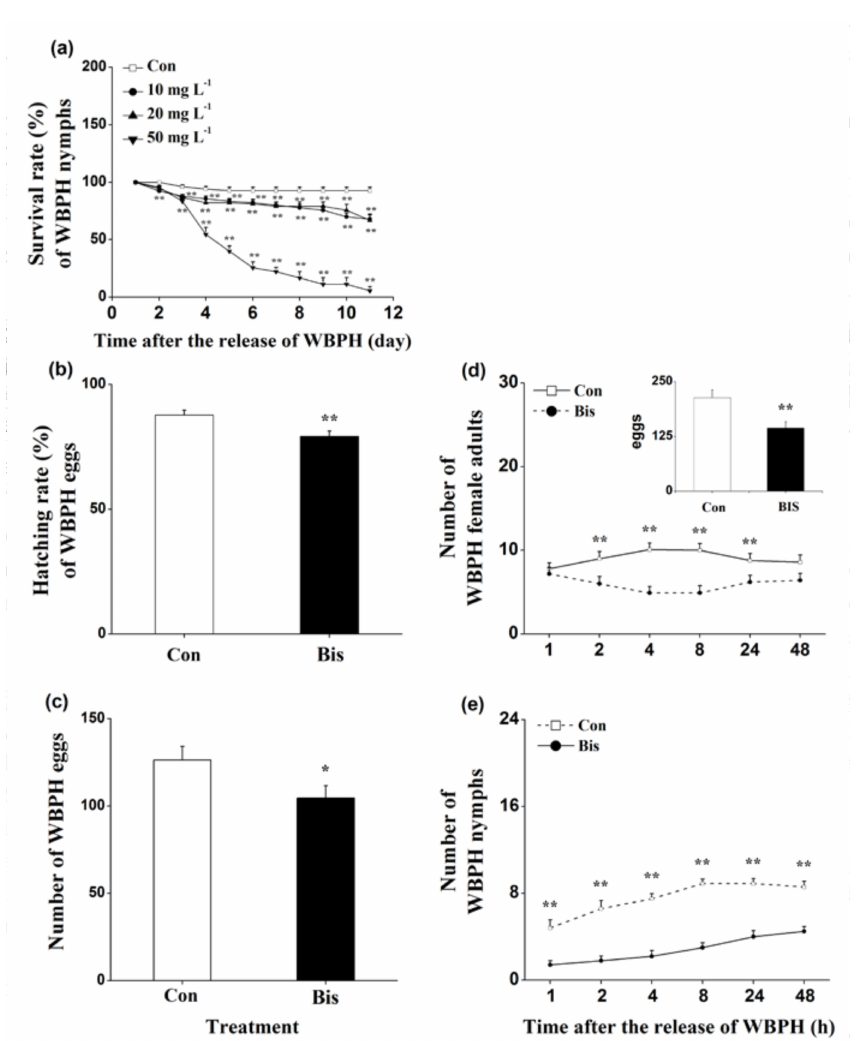
Figure 1. Bismerthiazol induces the direct resistance of rice to WBPH. ( a ) Mean survival rates (+ SE, n = 6) of 15 newly hatched WBPH nymphs fed on plants that had been grown in nutrient solution with either different concentrations of bismerthiazol (Bis) or without bismerthiazol (Con) for 24 h, 1–11 days after exposure; ( b ) Mean hatching rates (+SE, n = 10) of eggs laid over 12 h by 15 gravid WBPH females on plants that had been grown in nutrient solution with 50 mg L − 1 bismerthiazol (Bis) or without bismerthiazol (Con) for 24 h; ( c ) Mean numbers (+SE, n = 10) of eggs laid over 12 h by 15 female WBPH adults fed on plants that had been grown in nutrient solution with 50 mg L − 1 bismerthiazol (Bis) or without bismerthiazol (Con) for 24 h; ( d ) Mean number of gravid WBPH females (+SE, n = 10) fed on plants that had been grown in nutrient solution with 50 mg L − 1 bismerthiazol (Bis) or without bismerthiazol (Con) for 24 h, 1–48 h after exposure. Inset shows the mean percentage (+SE, n = 10) of WBPH eggs per plant on pairs of plants as stated above, 48 h after the release of WBPH; ( e ) Mean number of newly hatched WBPH nymphs (+SE, n = 10) on plants that had been grown in nutrient solution with 50 mg L − 1 bismerthiazol (Bis) or without bismerthiazol (Con) for 24 h, 1–48 h after exposure. For survival rate data, asterisks indicate significant differences in bismerthiazol-treated plants compared with non-treated plants (** p < 0.01; Duncan’s multiple-range test); for other data, asterisks indicate significant differences between members of a pair (* p < 0.05; ** p < 0.01; Student’s t